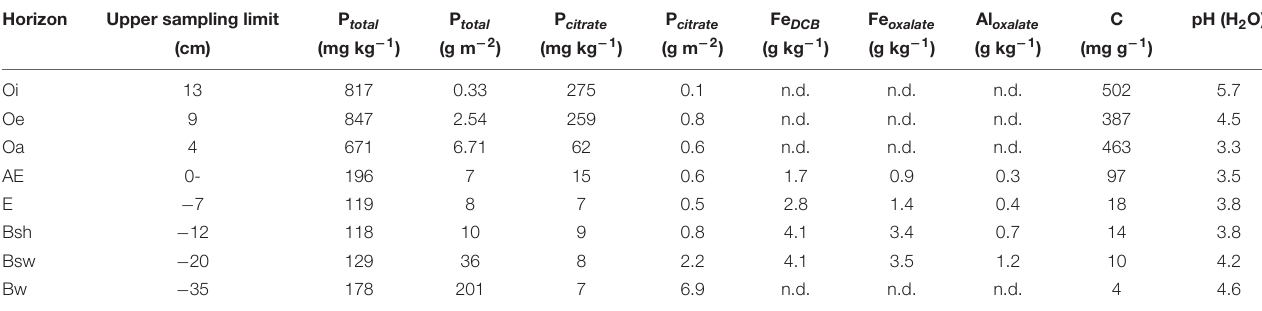
TABLE 1 | Soil characteristics of the Hyperdystric Folic Cambisol (Arenic, Loamic, Nechic, Protospodic) in the Lüss Forest (the Bw horizon extends from 35 to 106 cm soil depth). Horizon Upper sampling